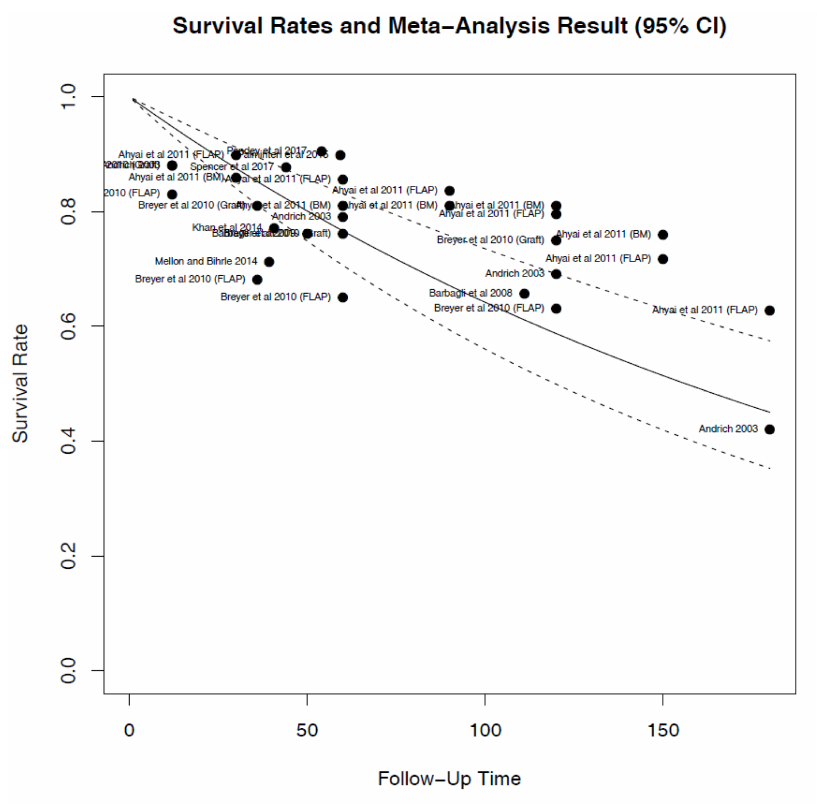
Figure 3 - Estimated Kaplan-Meier curve overlay on the survival rates from each study included in the